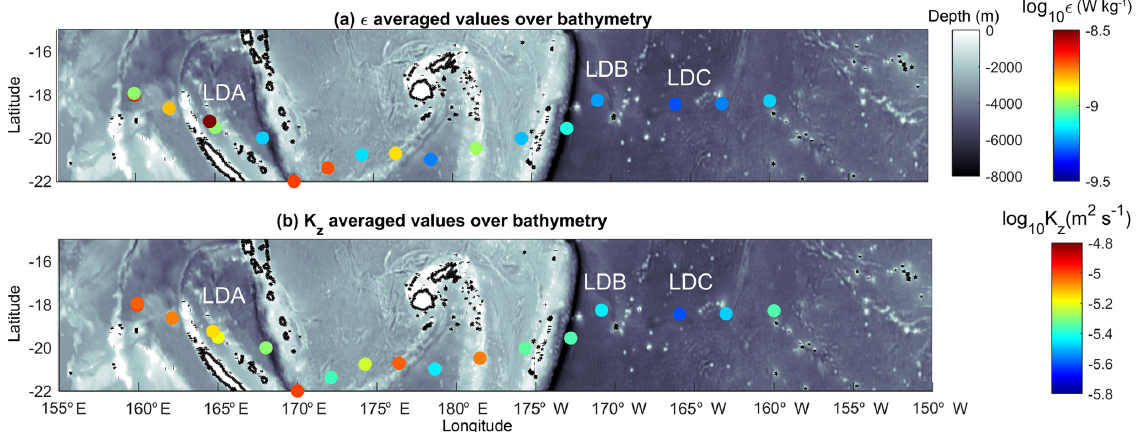
Figure 1. Dissipation rate of turbulent kinetic energy (a) and vertical diffusion coefficient (b) averaged below the mixed-layer depth (see Table 1 from Moutin et al., 2017), over 100–800m (log scale); bathymetry is shown with grey color scale (ETOPO1, 1arcmin, Amante and Eakins, 2009). Time-averaged values are displayed at long-duration stations LD-A, LD-B, and LD-C.